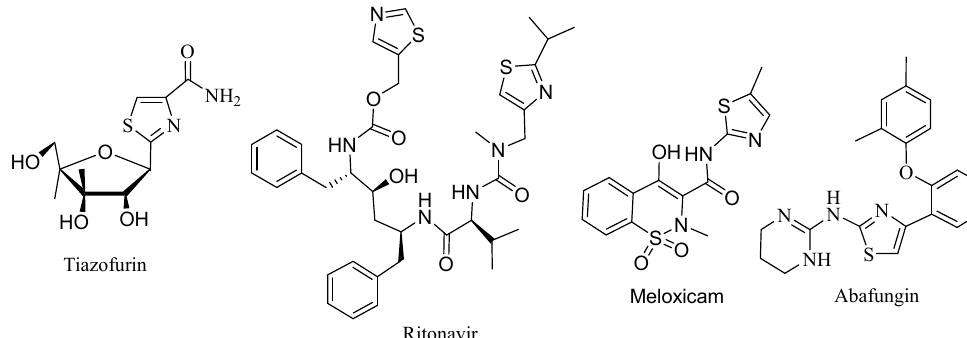
Figure 2. Approved drugs with thiazole scaffold.